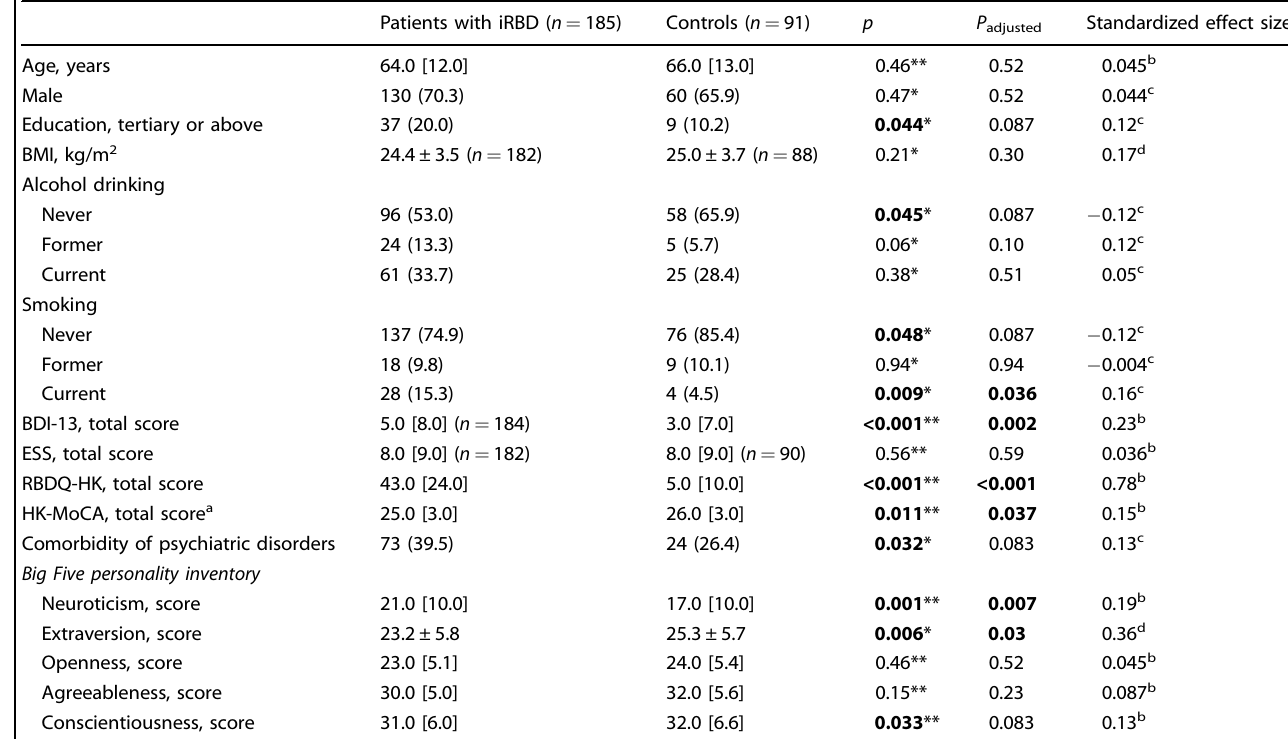
Table 1. Demographic characteristics, clinical features, and personality traits of iRBD patients and controls at baseline. Patients with iRBD ( n =